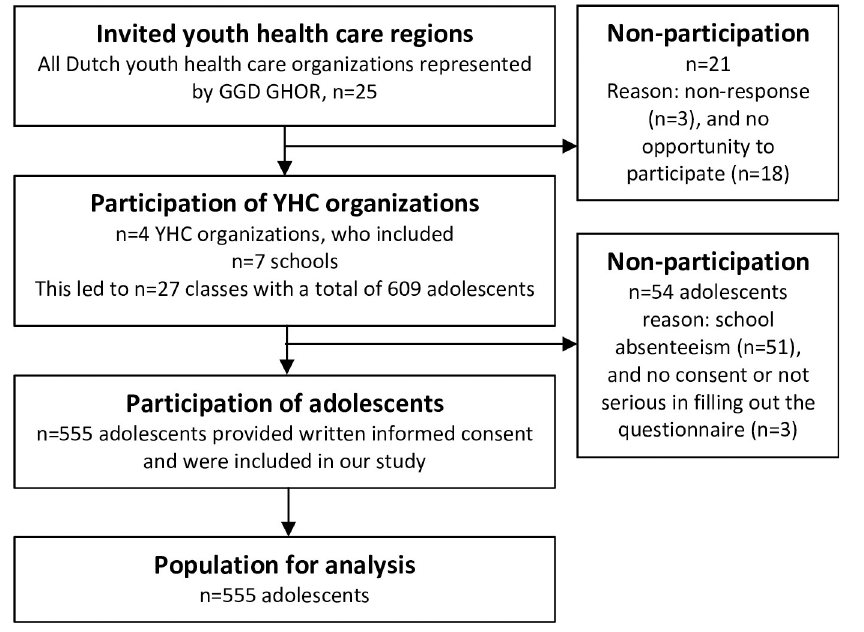
Fig 1. Flowchart of the study